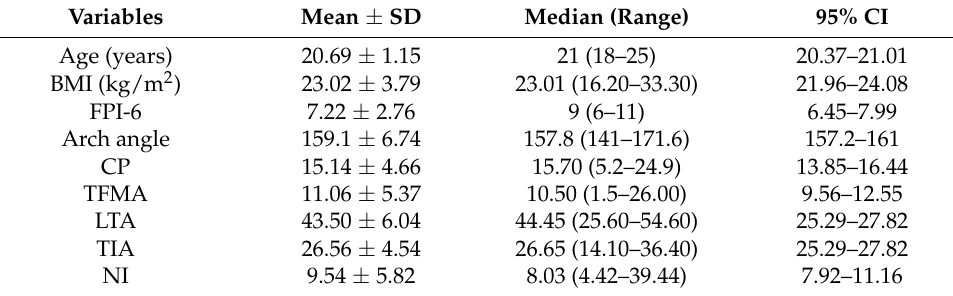
Table 1. Demographic characteristics and baseline scores ( n =